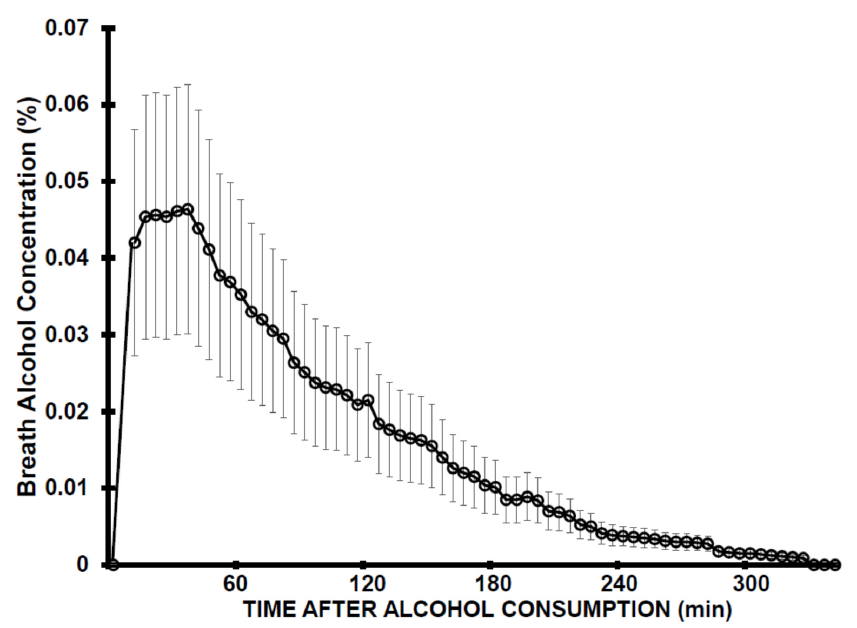
Figure 1. Breath alcohol concentration.